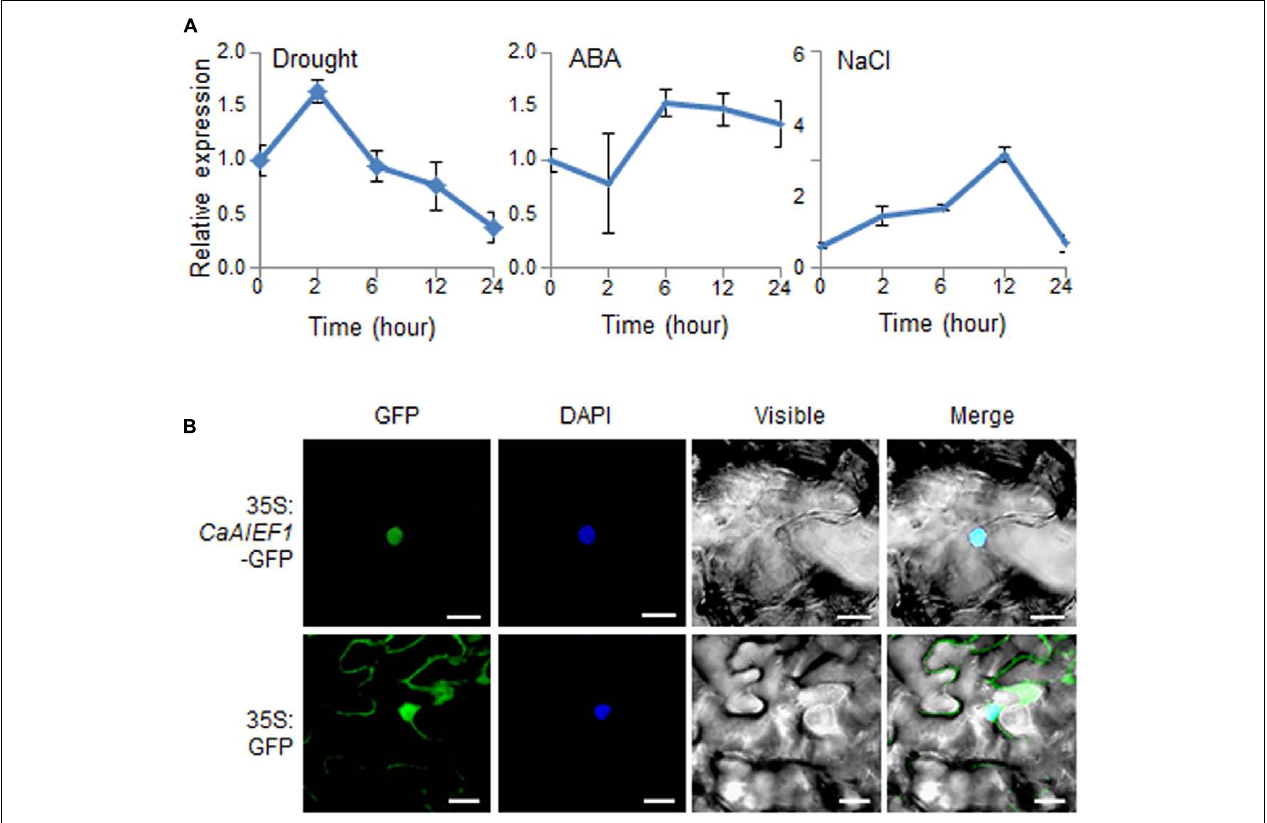
FIGURE 2 | Expression of CaAIEF1 and subcellular localization of CaAIEF1. (A) The expression pattern of the CaAIEF1 gene was analyzed in the leaves of pepper plants after treatment with 100 µ M abscisic acid (ABA), drought, or 200 mM NaCl. The pepper Actin1 gene was used as an internal control. (B) Subcellular localization of the 35S: CaAIEF1 -GFP fusion protein in N. benthamiana epidermal cells. The 35S: CaAIEF1 -GFP construct was expressed via agroinfiltration of N. benthamiana leaves and observed using a confocal laser-scanning microscope. 4 (cid:48) ,6-Diamidino-2-phenylindole (DAPI) staining was used as a marker for the nucleus. The scale bar represents 20 µ